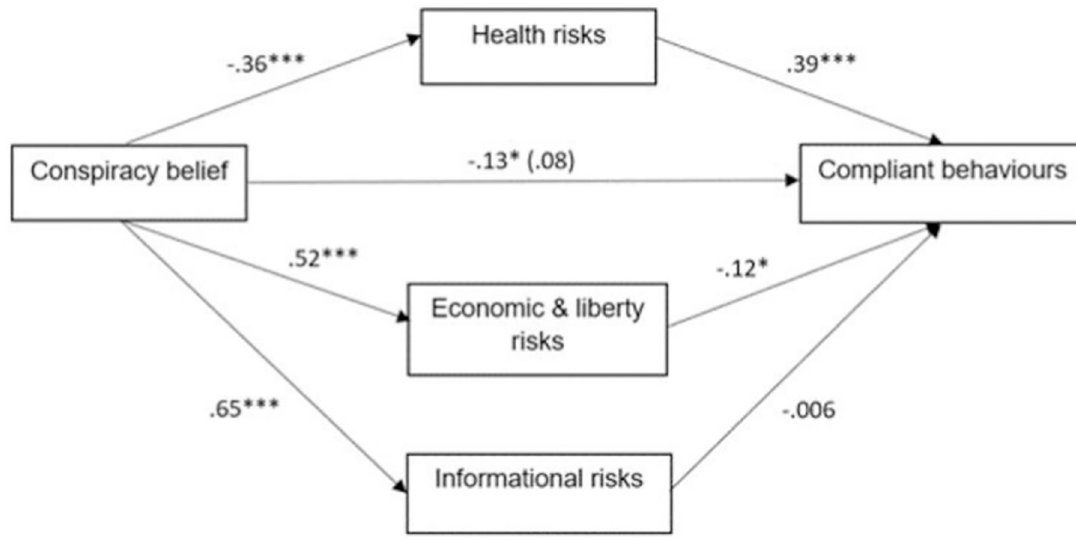
Fig 1. Parallel mediation model with conspiracy belief as the distal predictor. � p < .05. ��� p < .001.